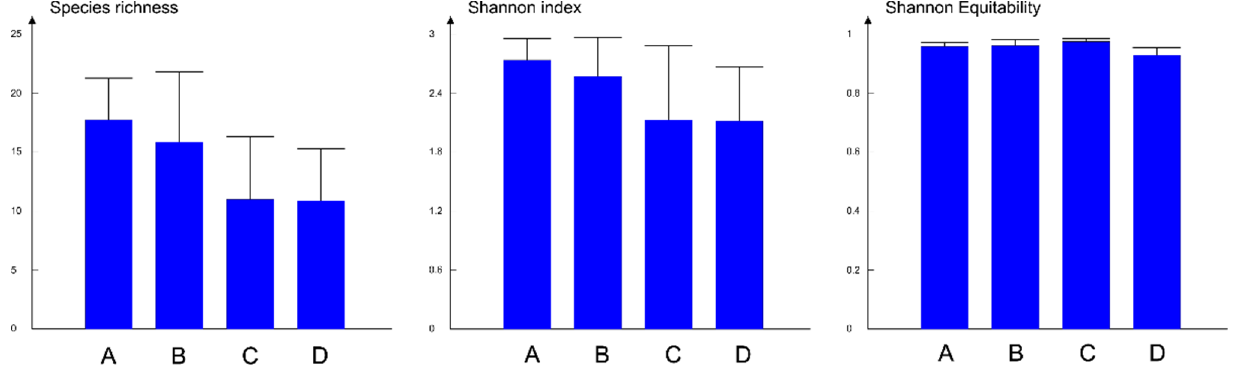
Figure 5. Components of alpha diversity in four types of chironomid assemblages, bars represent average values while lines denote the variance in each group of assemblages. The four community types are in capital letters A, B, C, D coloured as indicated.